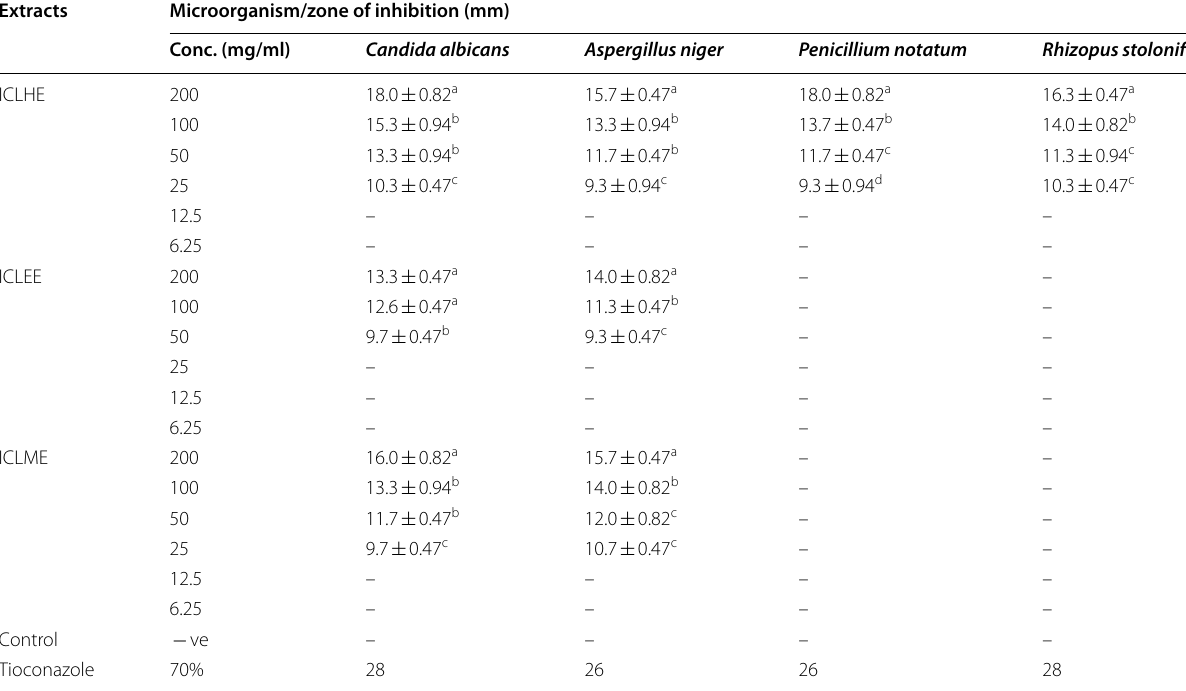
ICLHE-Hexane Extract of I. trichantha leaves; ICLEE-Ethylacetate Extract of I. trichantha leaves; ICLME-Methanol Extract I. trichantha leaves; – No Activity; concentrations with different superscripts are significantly different for each extract ( p < 0.05)